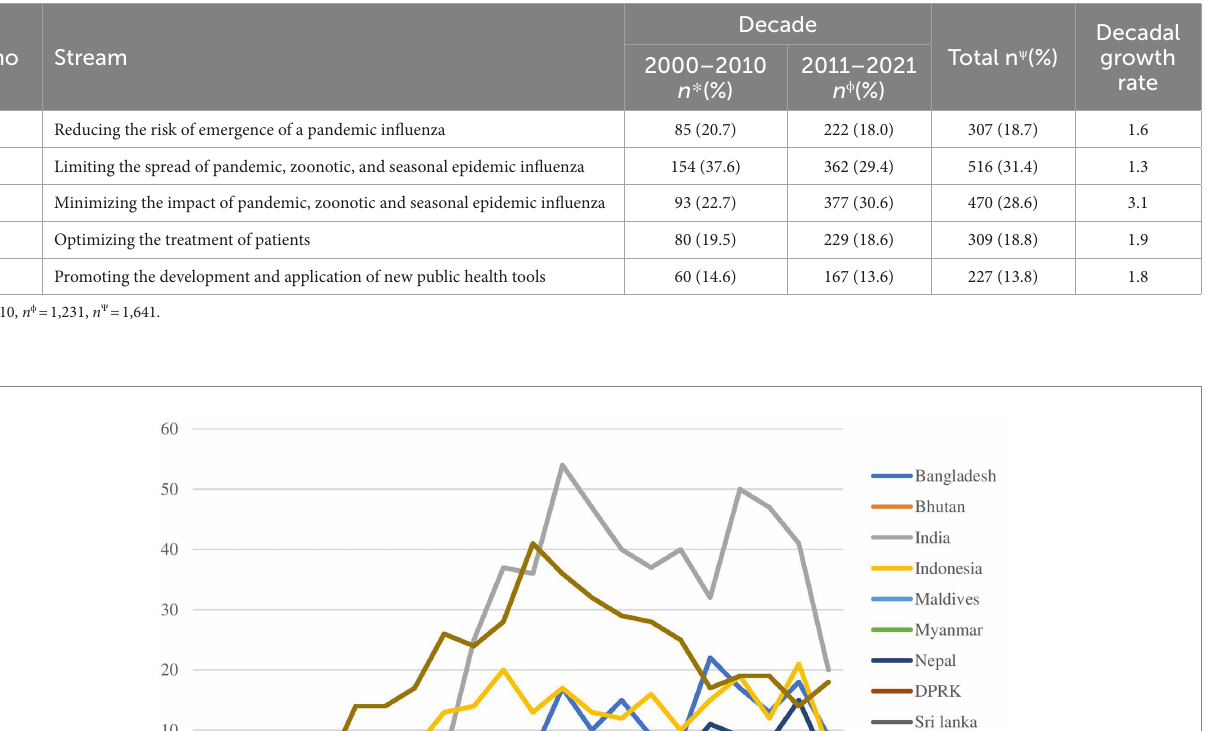
TABLE 1 Distribution of articles included in the review according to WHO Influenza Streams.